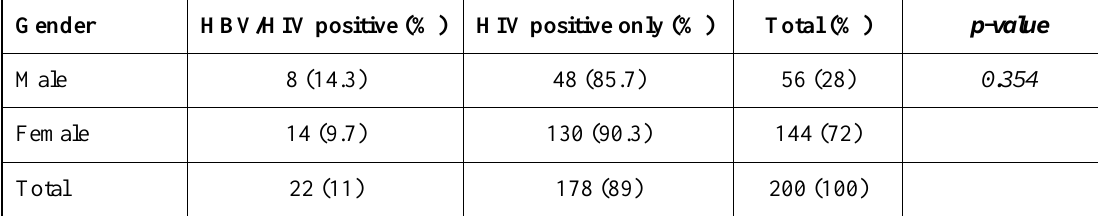
Table 1. Distribution of HBV co-infection in relation to gender.